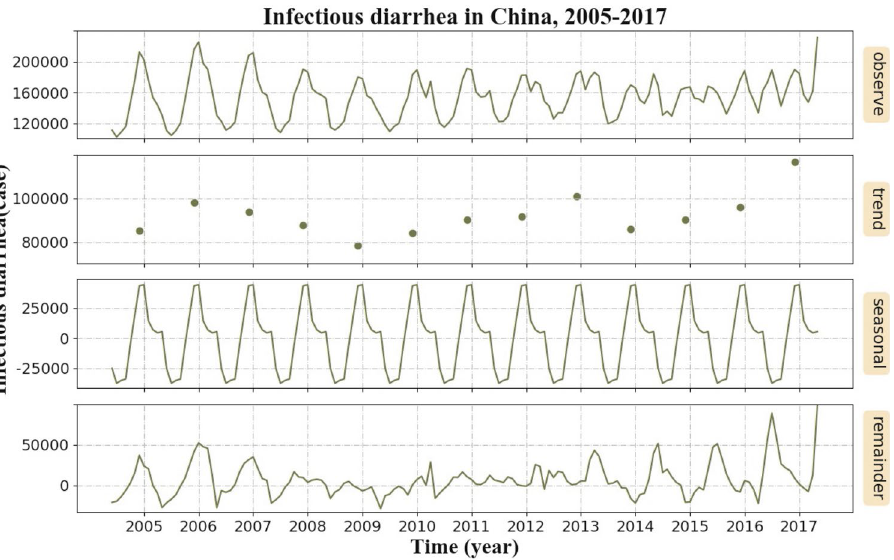
Figure 1. Monthly observed cases of infectious diarrhea in mainland of China, 2005–2017. Note: From top to bottom, the lines represent actually observed cases, trend components, seasonal components, and random components,